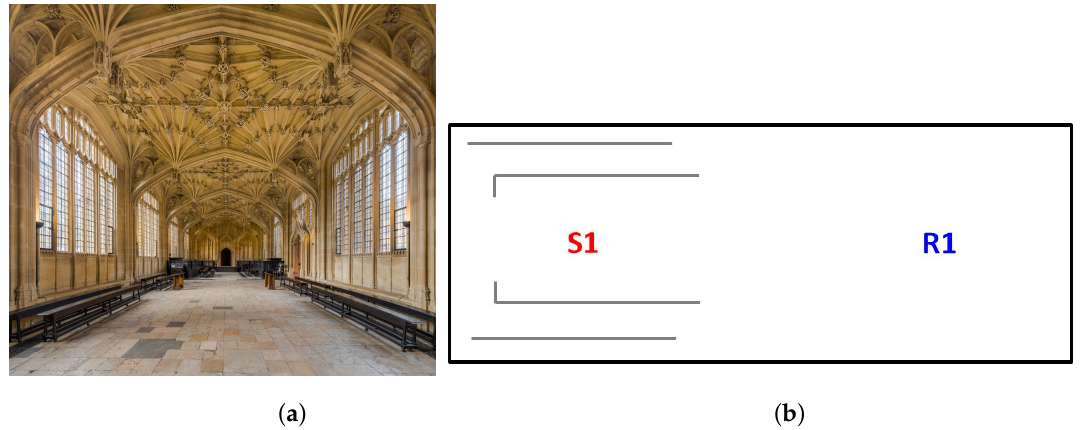
Figure 13. ( a ) Divinity School, University of Oxford, photo by DAVID ILIFF. Licence: CC BY-SA 3.0 via Wikimedia Commons [47] and ( b ) floor plan of the measured position.